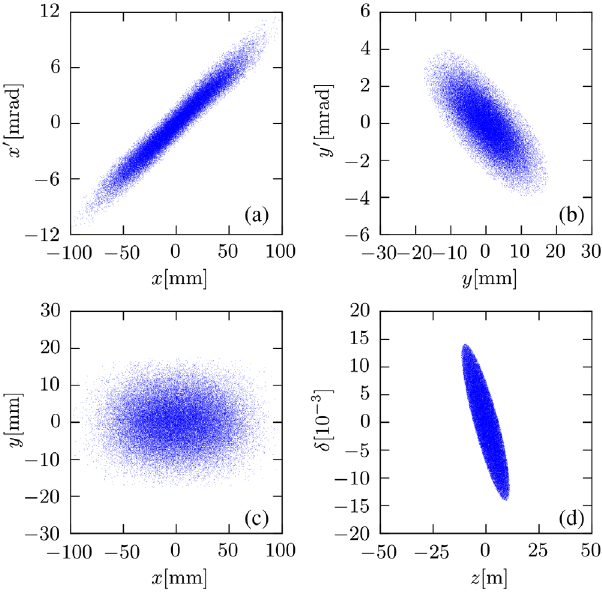
FIG. 13. Particle distribution in (a) x − x 0 phase space; (b) y − y 0 phase space; (c) x − y space; and (d) longitudinal z − δ phase space at 70th turn during bunch compression, with 122 °, k 104 °. k 0 0 ;y ¼ ;x ¼